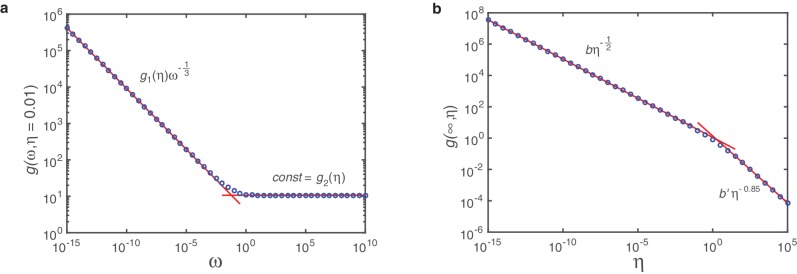
Fit of g⁢(ω,η) on log-log scale.The function g⁢(ω,η)=∫0∞Aω,η⁢(t)⁢𝑑t describes (half) the travelled distance of the profile of the polymer size distribution in dependence of ω=αν⁢C and η=μν. Marker points show solutions for g⁢(ω,η) as obtained numerically from integration of Equation A26. Red lines are linear fits on log-log scale. In (a) we plot g⁢(ω,η) for fixed η (here exemplarily for η= 0.01) over 25 orders of magnitude in ω and find a markedly bipartite behavior: For small ω the dependence on ω is perfectly matched by a power law with exponent −13 and η-dependent coefficient g1⁢(η), whereas for large ω it is a constant g2⁢(η). (b) Plotting g2(η)=g(ω=∞,η) in dependence of η reveals again strictly bipartite behavior. Here, however, only the branch for small η≤1 is relevant. With the coefficient g1⁢(η) that can be determined in a similar way this leads to the final form of g⁢(ω,η) as given by Equation A46.